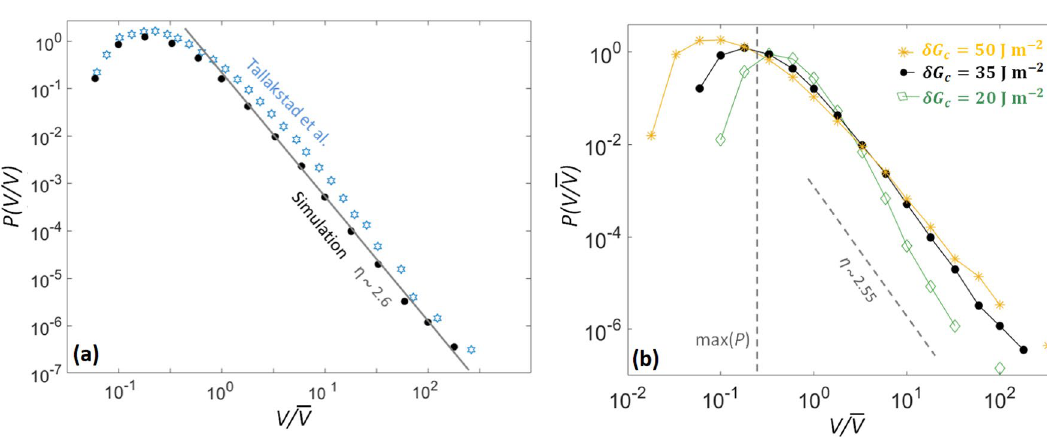
Figure 5. ( a ) Probability density function of the local propagation velocity along a simulated front (plain points), computed from the space-time map of Fig. 3d. The experimental probability 28 (out of Fig. 5, Expt. 5 of the experimental paper) is shown for comparison (hollow stars). The continuous line has a slope − 2.6 , close to that of the experimental points. This was achieved by setting the standard deviation for the disorder in fracture energy to 35J m − 2 . The numerical η , obtained with a linear root mean square fit of the distribution tail, is estimated as η = 2.6 ± 0.1 . ( b ) The same distribution for three three simulations with different values of δ G c . We chose the value of δ G c by tuning it and fitting the slope and maximum of the experimental data, which are illustrated by the dashed lines. The rest of the parameters used in these simulations are as defined in Table 1. Note that the ability of the model to reproduce the local velocity distribution was already shown by Cochard et al. 8 (see text for explanation and